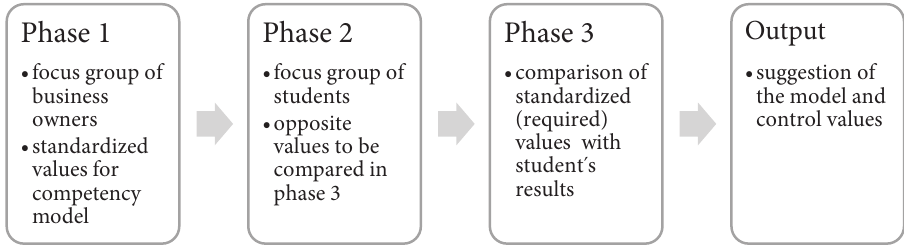
Figure 1. The research